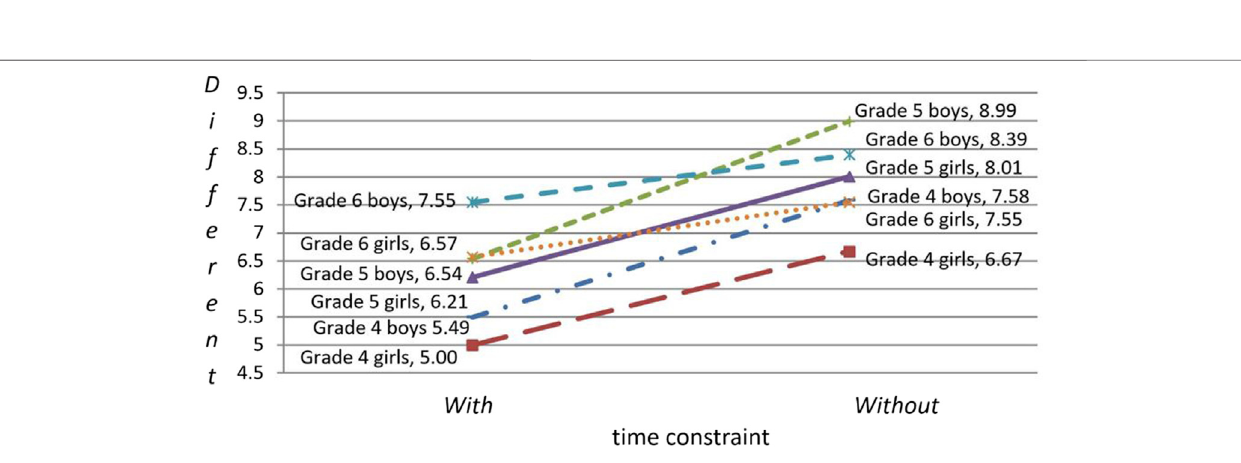
FIGURE 3 | Gender differences by time constraint and grade in Different item